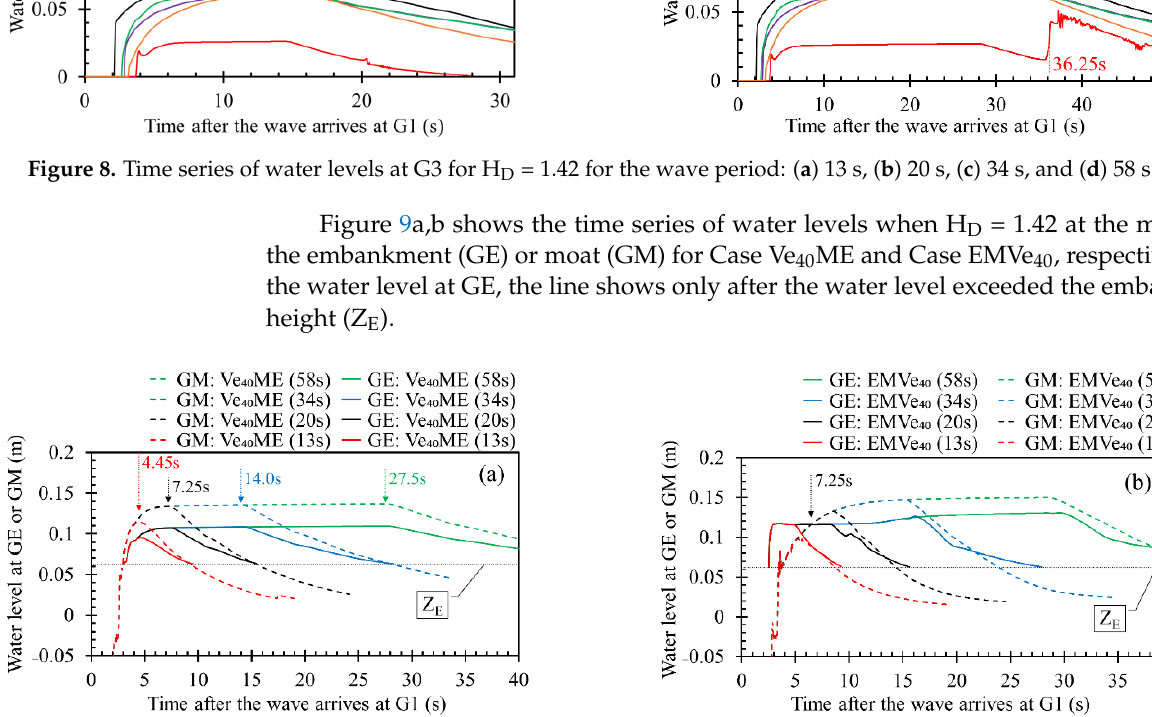
Figure 9. Time series of water levels when H D = 1.42. ( a ) At the middle of the embankment or at the middle of the moat for Case Ve 40 ME, ( b ) at the middle of the embankment (GE), or at the middle of the moat (GM) for Case EMVe 40.